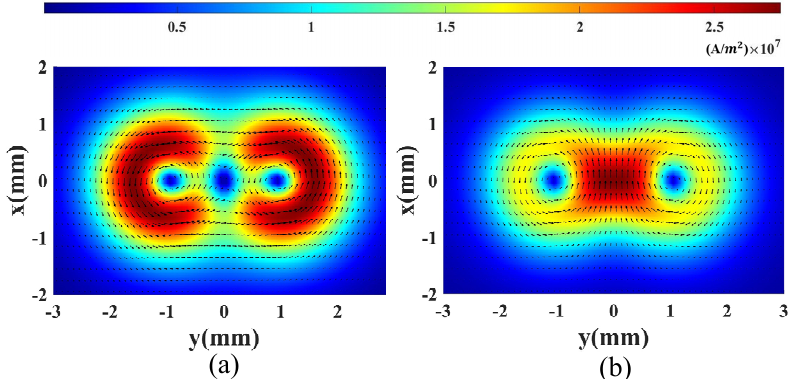
Figure 4. Induced eddy current in a defect-free conductive sample with ( a ) SD and ( b ) OD excitation. The output signals of the coils are numerically calculated using the FEM model. A small defect with dimensions of 0.4 mm (length) × 0.2 mm (width) × 0.2 mm (depth) is